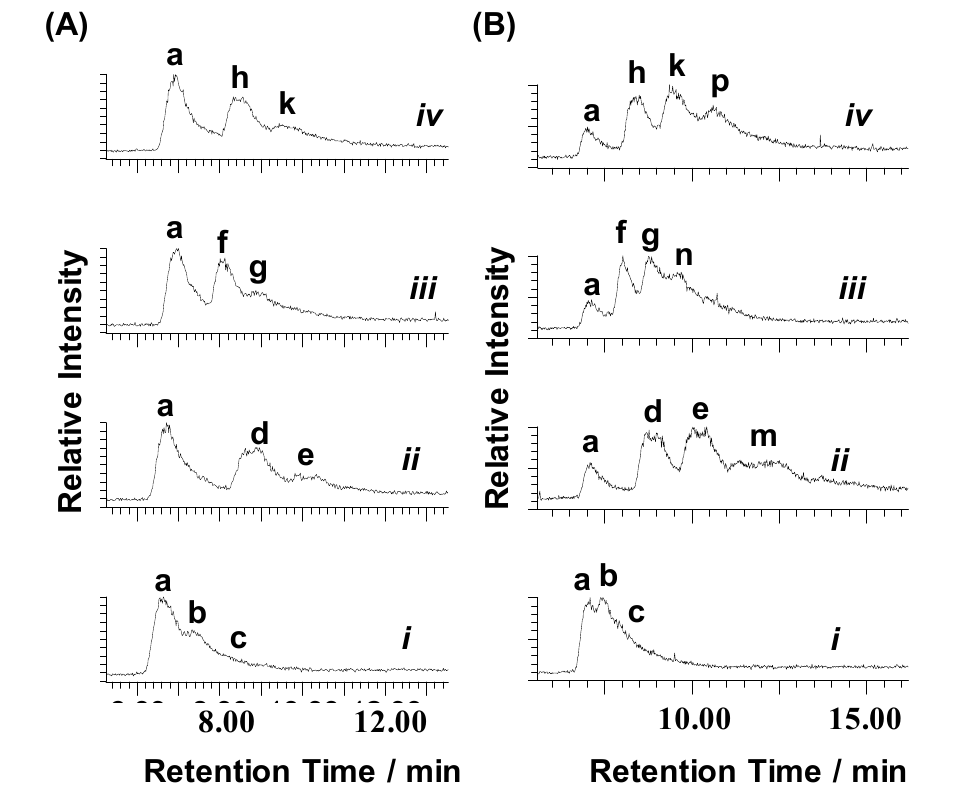
Figure 4. Total ion count (TIC) chromatograms for reactions of complex 1 ( i ), 2 ( ii ), 3 ( iii ), or 4 ( iv ) with single strand II (0.1 mM) at the molar ratio of ( A ) Ru/ II = 1.0 or ( B ) Ru/ II = 3.0 in 50 mM TEAA (pH 7) at 310 K for 24 h. Peak assignments: a, unruthenated strand II ; b, d, f, and h, mono-ruthenated II ; c, e, g, and k, di-ruthenated II ; m, n, and p, tri-ruthenated II . Notably the fraction c in ( B ) contains a little tri-ruthenated II by 1 and fractions n and p contains a small amount of tetra-ruthenated II by 3 or 4 as shown in Figure S8 in supplementary materials. Table 3. Negative ions observed by ESI-MS for the HPLC fractions shown in Figure 4 (for mass spectra, see Figure S8 in supplementary materials).